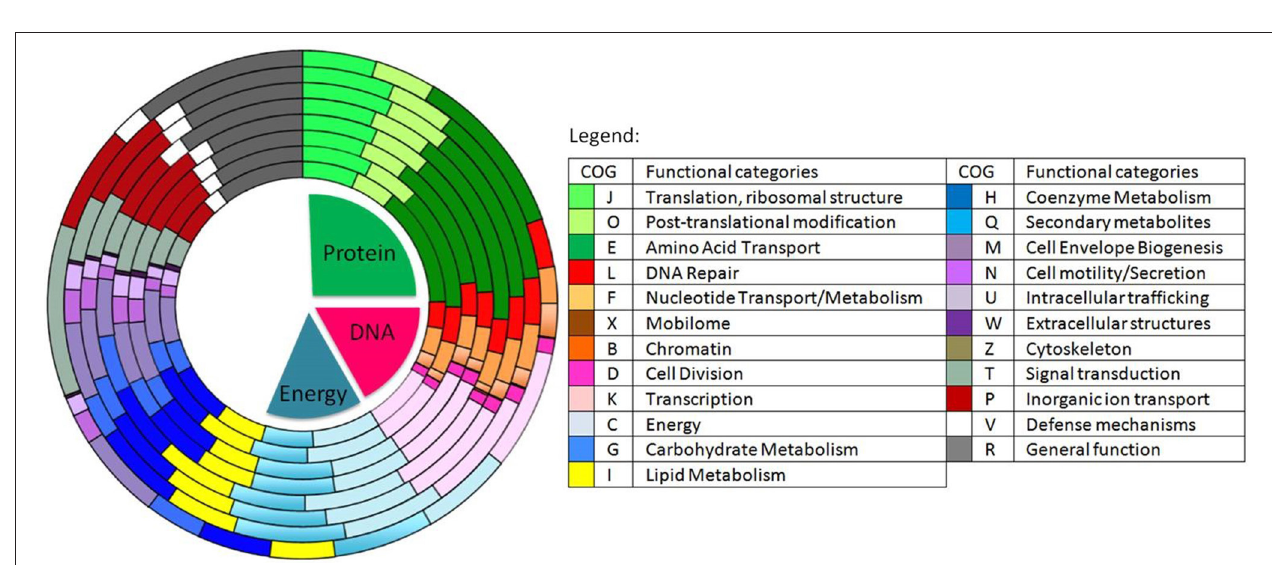
FIGURE 2 | Distribution of proteins into COG categories of the theoretical (gray) and the expressed proteome (black).